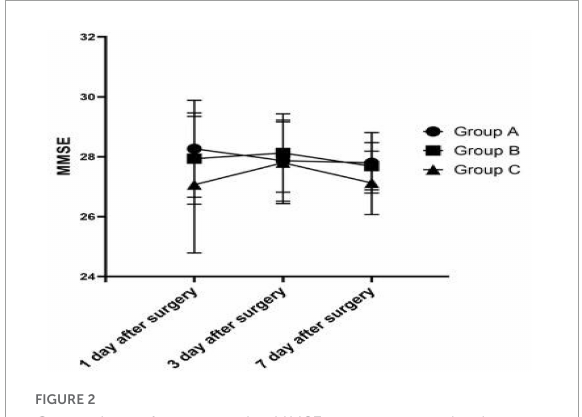
FIGURE2 Comparison of postoperative MMSE scores among the three groups.